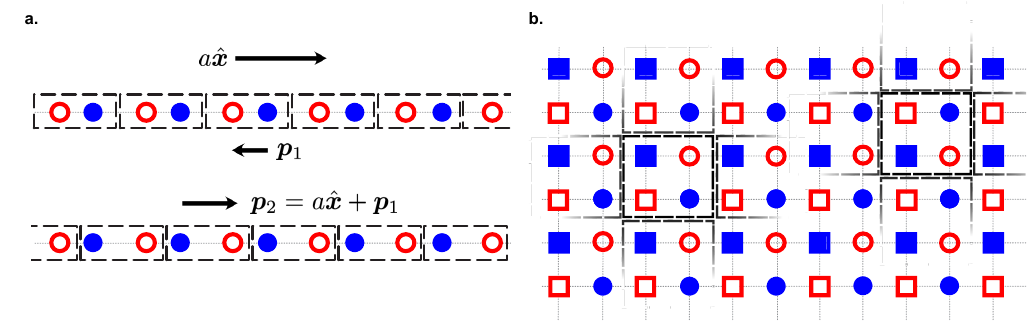
Figure 3: Inferring the band topology from frame geometry . a. The two-sites Wigner-Seitz cell on a 1D chiral frame have different geometrical polarizations; their difference is given by one Bravais vector. Consequently, we can always define the unit cell so that the Bloch Hamiltonian has a finite winding. b. All the Wigner-Seitz unit cells on the checkerboard lattice share the same (vanishing) chiral polarization. Therefore a single winding number w characterizes the Hamiltonians on this frame in virtue of Eq. (11). Evaluating the winding using the Wigner-Seitz cell compatible with the atomic limit of H yields w = 0, by